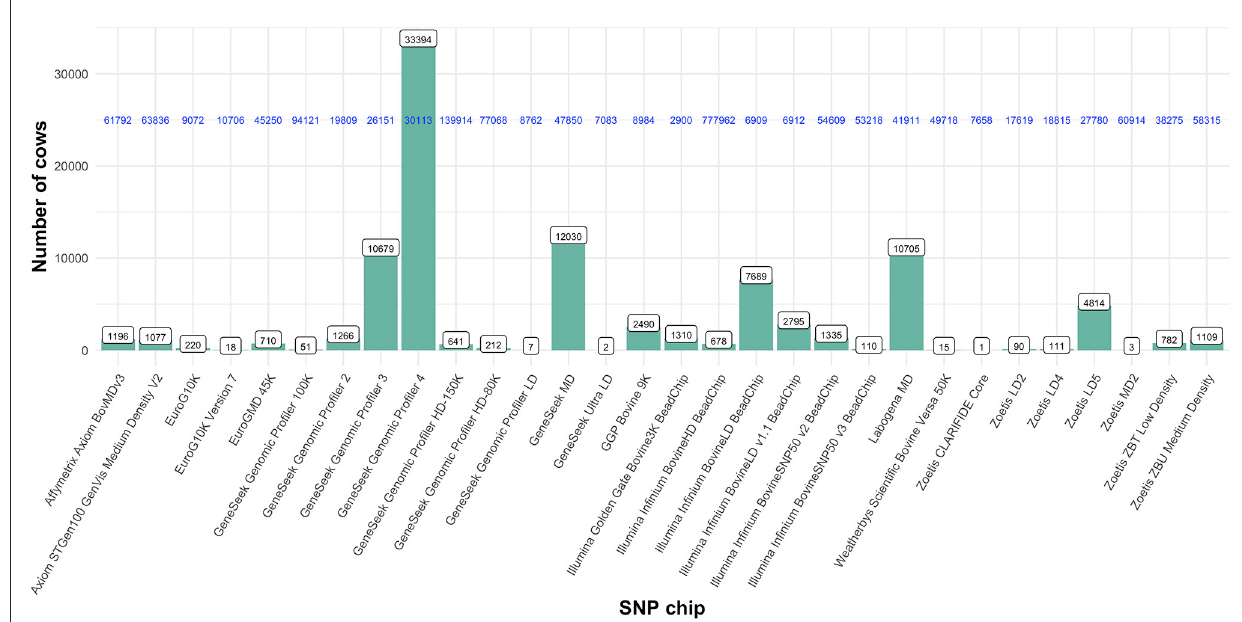
FIGURE1 Cows and genotype panels available from which were selected two high density SNP panels (Illumina Infinium BovineHD BeadChip and GeneSeek Genomic Profiler HD-150K) and four medium density SNP panels (GeneSeek Genomic Profiler 3, GeneSeekGenomic Profiler 4, GeneSeek MD and Labogena MD). Numbers on the top of the bars show the number of cows genotyped within each SNP panel. Horizontal numbers in blue show the total number of SNP included in each SNP